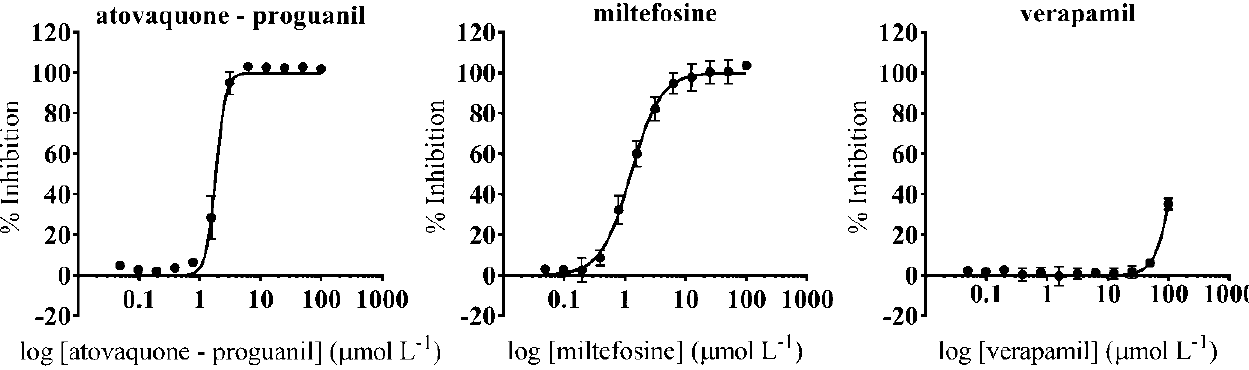
Figure 6. Dose-response curves of progressed drugs that can be orally administered in the anti-amastigote assay.